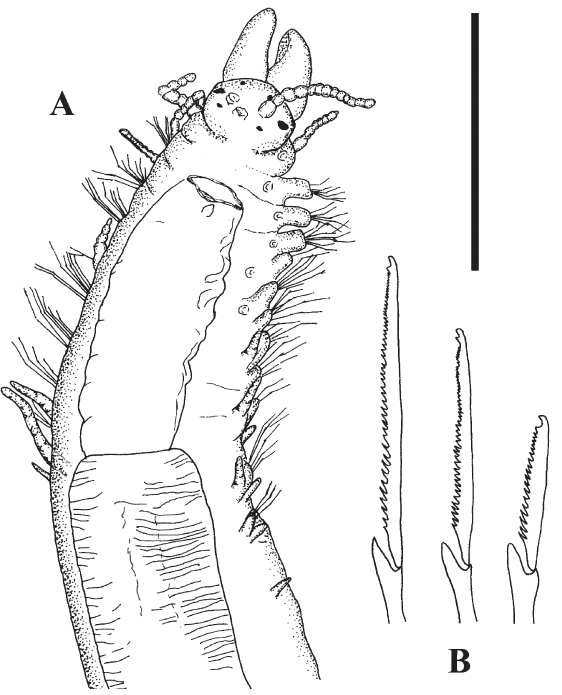
Fig . 5. – Paraehlersia cf. dionisi . A, anterior end, dorsal view; B, anterior chaetae. Scale bars: A, 500 µm; B, 50